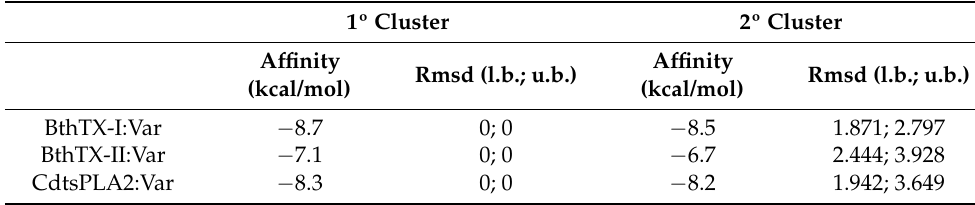
Table 3. Binding free energy (affinity) and rmsd values of each toxin with Var. 1º Cluster